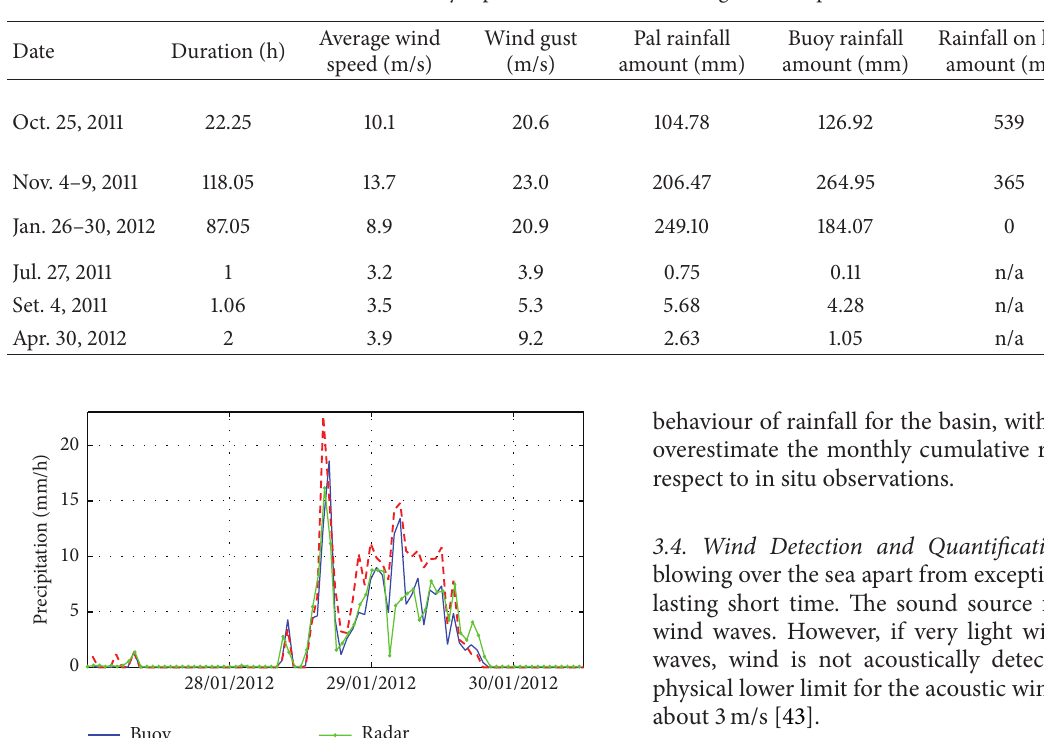
Table 3: Synoptic events occurred during LiSAE experiment.